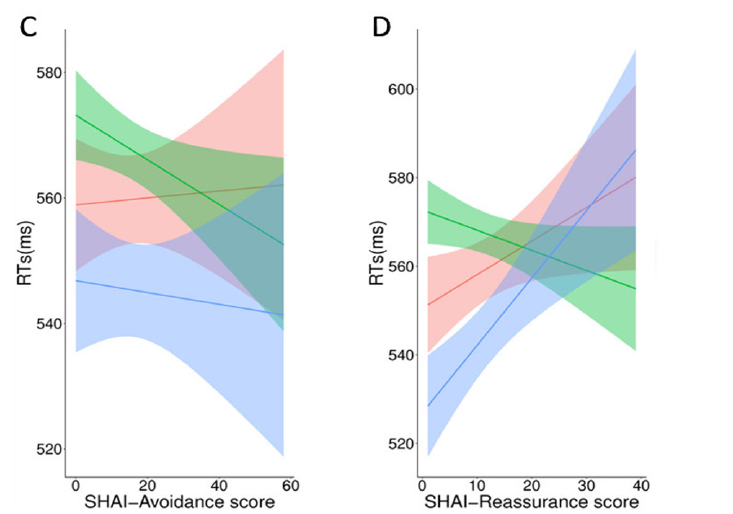
Figure 2. RTs for positive, negative and neutral words as function of the scores at ASI-3 ( A ), SHAI -negative consequences ( B ), SHAI-avoidance ( C ) and SHAI-reassurance ( D ).